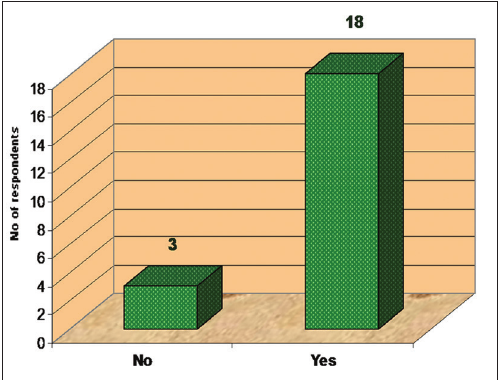
FIGURE 1. Patients’ satisfaction. Answer to question „Would you recommend Prolotherapy to other patients with similar condition?” improvement from baseline in pain intensity mea- sured by VAS 0-10 and shoulder function